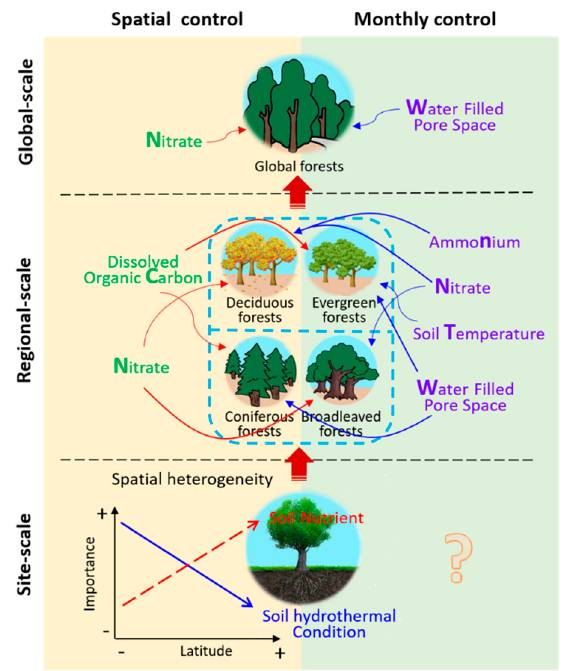
Figure 9. Comparison of key edaphic factors involved in controlling N 2 O fluxes on global, regional, and site scales.